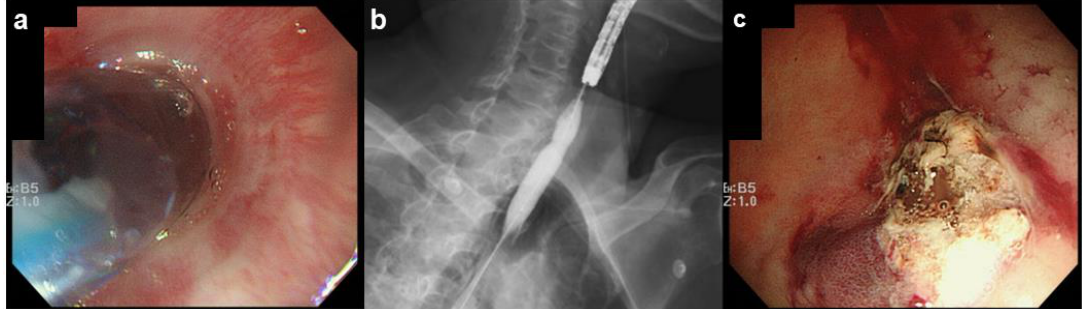
Figure 3. Endoscopic balloon dilation to facilitate thermal therapy at the bleeding point. ( a ) Endoscopic image during dilation; ( b ) radiograph during dilation; ( c ) endoscopic image after thermal therapy. The visible vessel has been cauterized, leading to complete hemostasis.